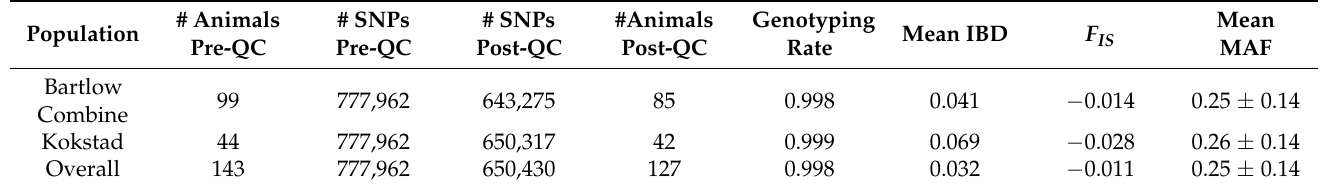
Table 1. Number of autosomal SNPs and individuals before (pre-) and after (post-) quality control (QC) per